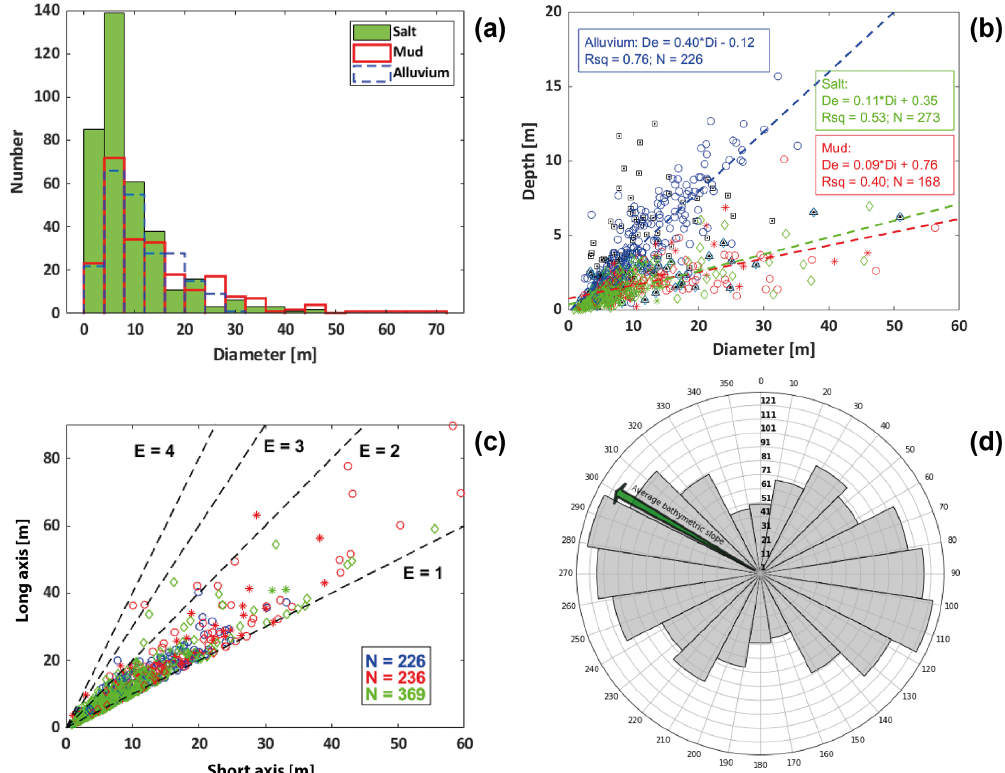
Figure 5. Morphological characteristics of the sinkhole population developed at Ghor al-Haditha in various sedimentary materials. (a) Num- ber of holes binned according to average diameter, (b) the relationship between depth and diameter and (c) plan-view eccentricity (longest to shortest diameter). (d) Rose diagram of azimuth of the long axes of all sinkholes in the study area with the average aspect of bathymetric slope plotted for comparison (green arrow). Each concentric circle represents a count of 10 sinkholes. The total number of holes analysed is 226 in the alluvium, 236 in the mud-dominated lacustrine deposits (“mud”) and 369 in the salt-dominated deposits (“salt”). Water-filled holes were excluded from the depth-to-diameter analysis. The De / Di plot presents the maximum elevation difference between the rim and the bottom of each sinkhole. Black squares in (b) are De / Di for sinkholes formed in alluvium at numerous sites along the Dead Sea’s western shore derived from Filin et al. (2011); the black triangles are De / Di for sinkholes formed in mudflats along the western shore also derived from Filin et al.